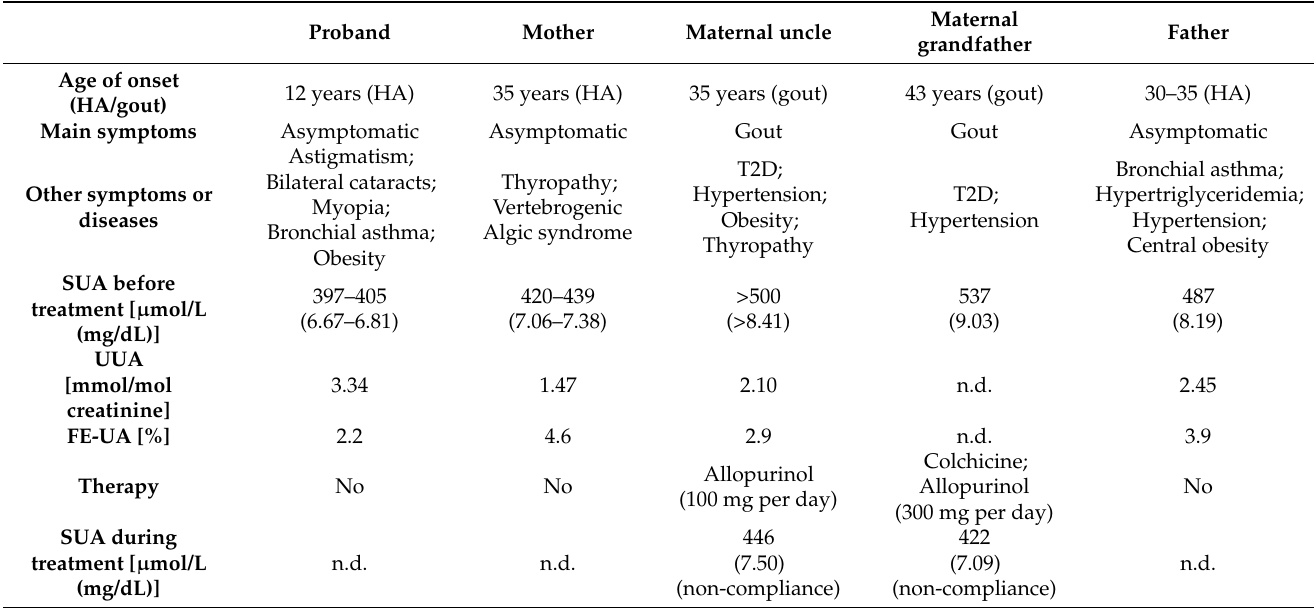
Table 1. Clinical and biochemical data of a family with early-onset hyperuricemia and